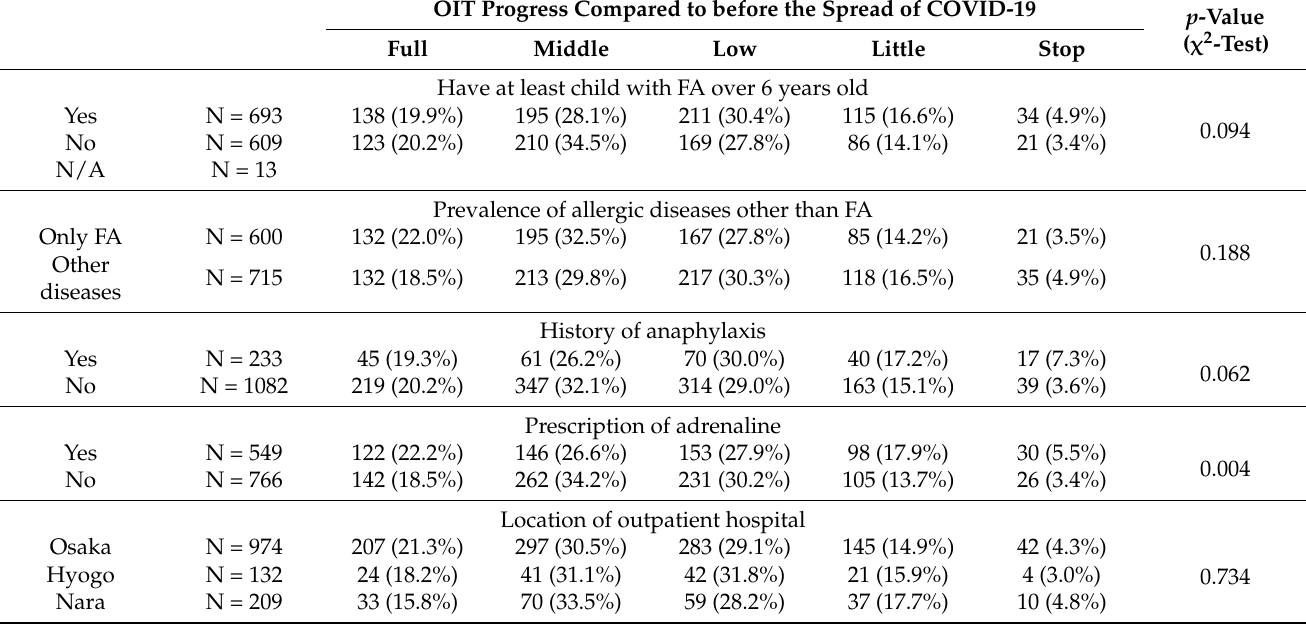
Table 2. Relationship between the subject’s information and the oral immunotherapy (OIT) progress during the first state of